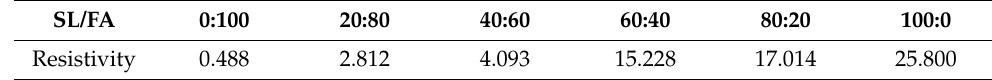
Table 6. Changes in resistivity of specimens with SL/FA [28].